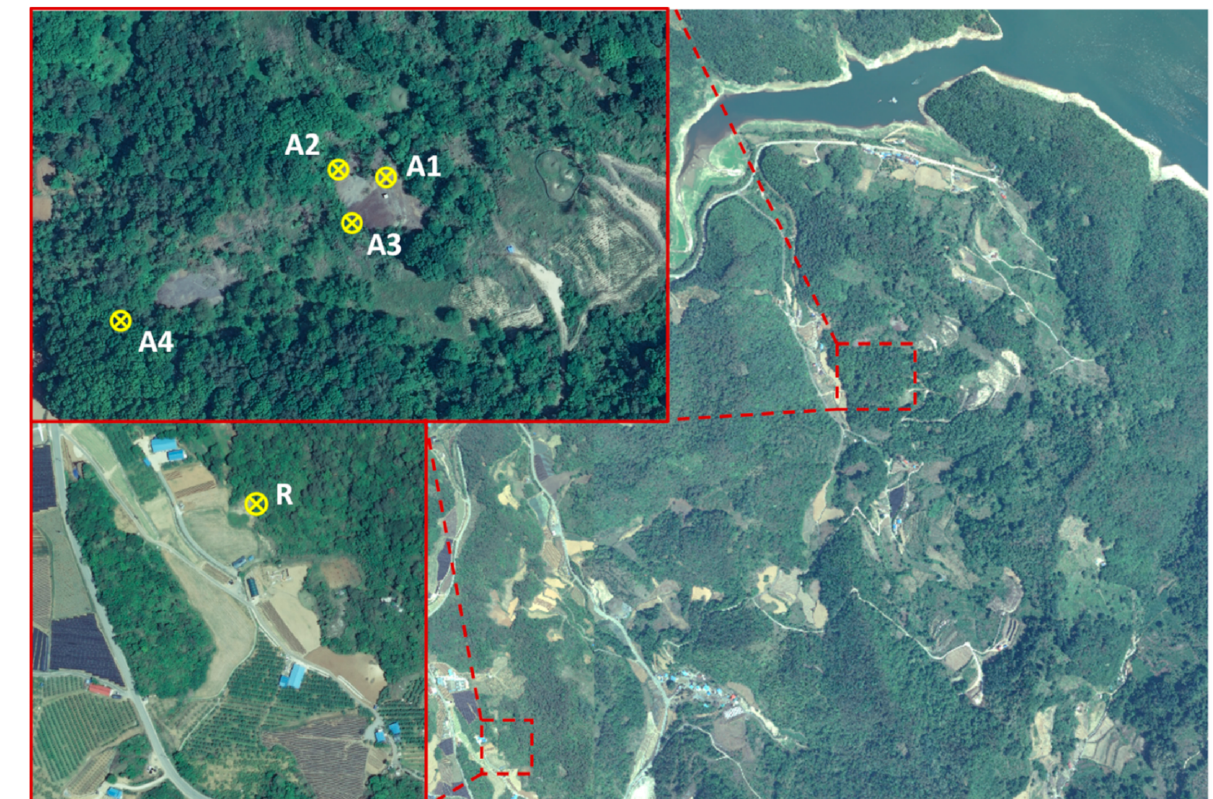
Figure 1. Image of the study site. The yellow circles show each sampling area. The aerial photograph was provided by the National Geographic Information Institute of Korea (https://www.ngii.go.kr, accessed 10 May